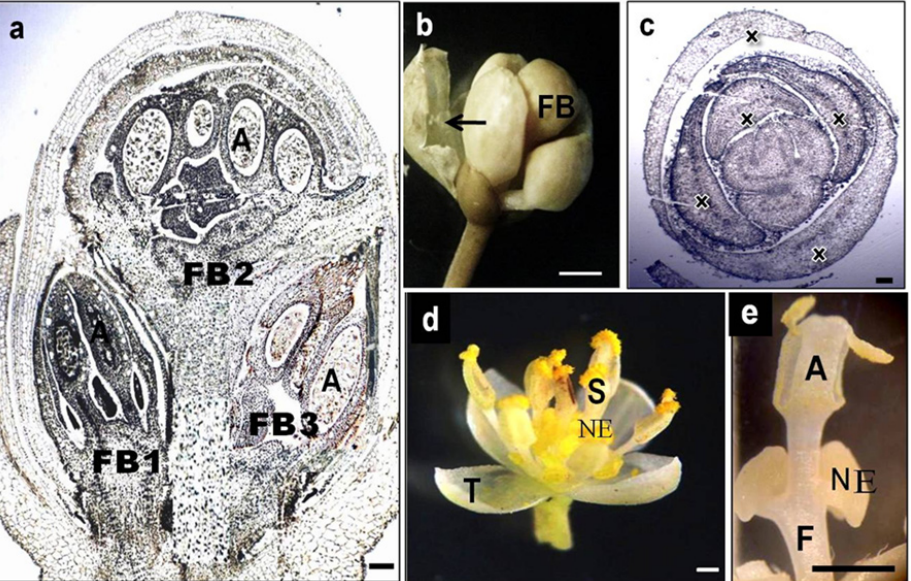
Fig. 1. a. Longitudinal section of male group with 3 flower buds, Bar 200 μm ; b. Flower buds group is covered by bud scales (→), Bar 1 mm ; c. Longitudinal sections of young flower with bud scales (x), Bar 100 μm ; d. Stereomicrograph of a mature male flower, Bar 1 mm ; e. Stereomicrograph of a stamen with opened valves, Bar 1 mm ; T-Tepal; FB-Flower bud; A-Anther; S-Stamen; NE- Nectarium;